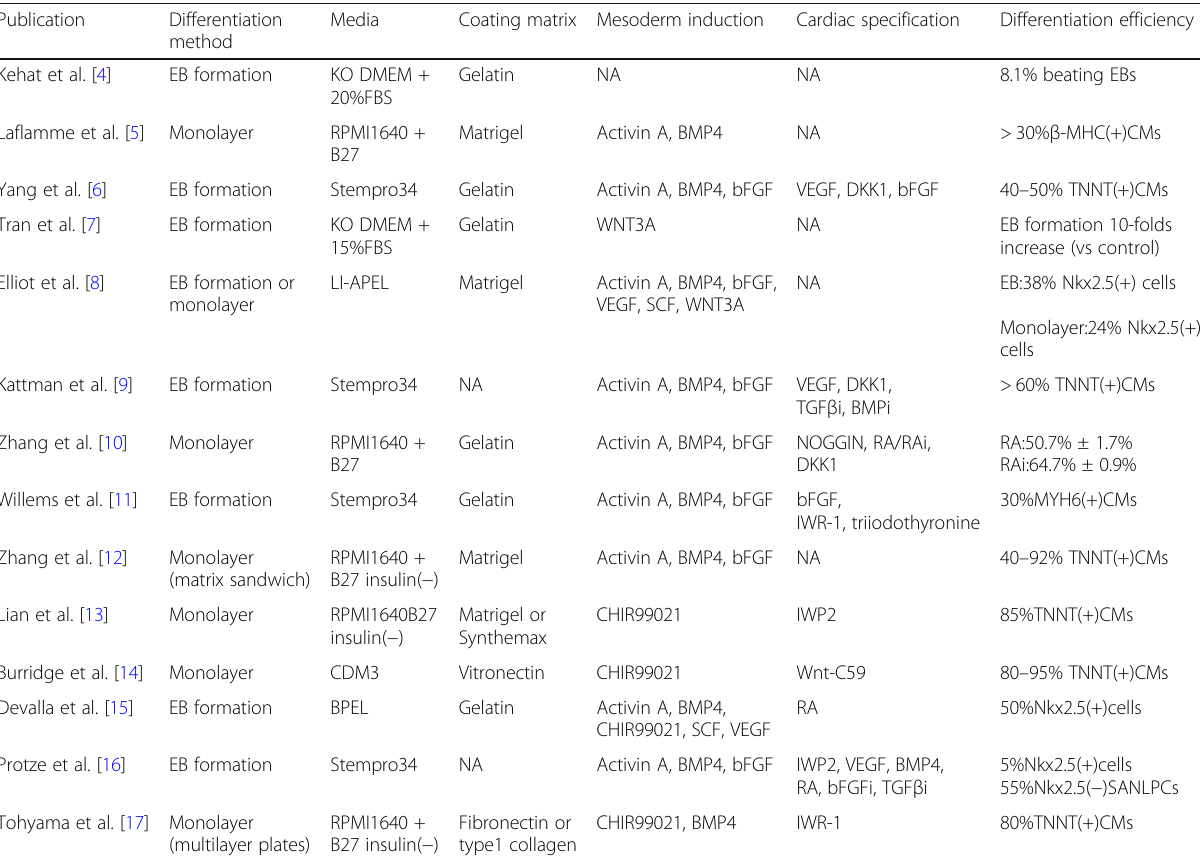
Modified table taken from [18] Abbreviations: bFGF basic fibroblast growth factor, bFGFi bFGF inhibitor, BMP bone morphologic protein, BMPi BMP inhibitor, CMs cardiomyocytes, DKK Dickkopf, DMSO dimethyl sulfoxide, EB embryoid body, FBS fetal bovine serum, KO knockout, MLC myosin light chain, N/A not applicable or not available, TGF β transforming growth factor β , TGF β i TGF β inhibitor, TNNT troponin T, SALPC sinoatrial node-like progenitor cells, SCF stem cell factor, VEGF vascular endothelial growth